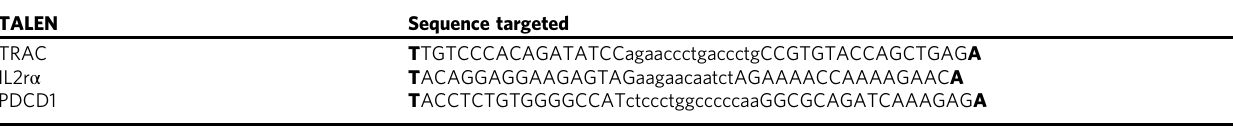
Table 2 TALEN targets used in the study TALEN Sequence